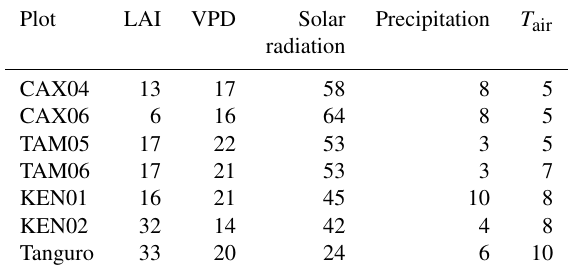
Table 7. The relative importance of LAI, VPD, solar radiation, pre- cipitation and air temperature ( T air ) in driving monthly variation in GPP (%). Monthly GPP estimates are derived from calibrated SPA simulations for seven permanent sample plots across an Ama- zon MCWD gradient, constrained using monthly field LAI mea- surements. Relative importance values were derived from analyses using the random forest technique ( n =